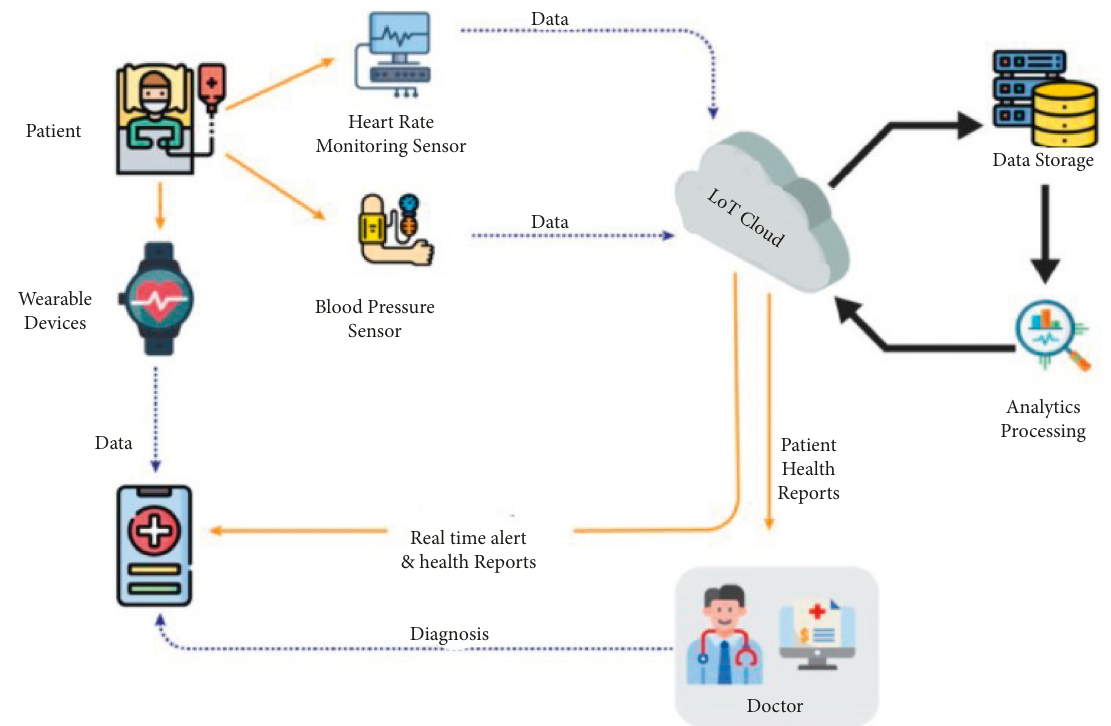
Figure 3: Impact of IoT on healthcare